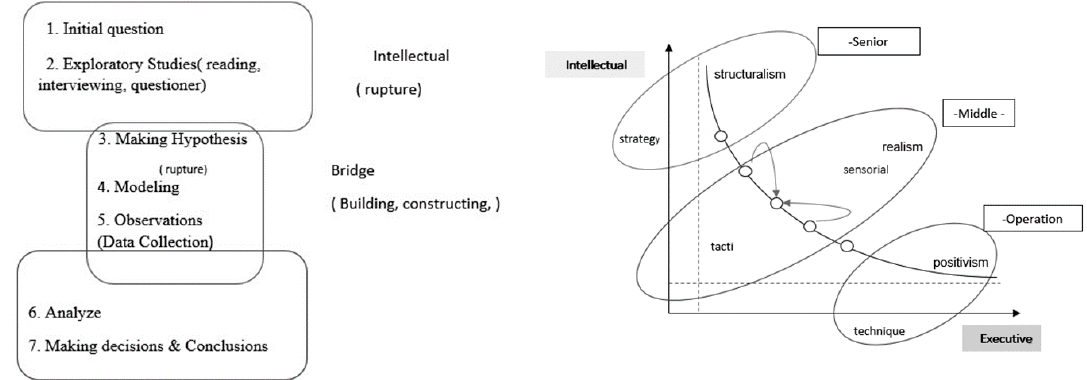
Figure 3. Revised diagram concerning the Kiwi and Kampenhood methodology and its levels [7].